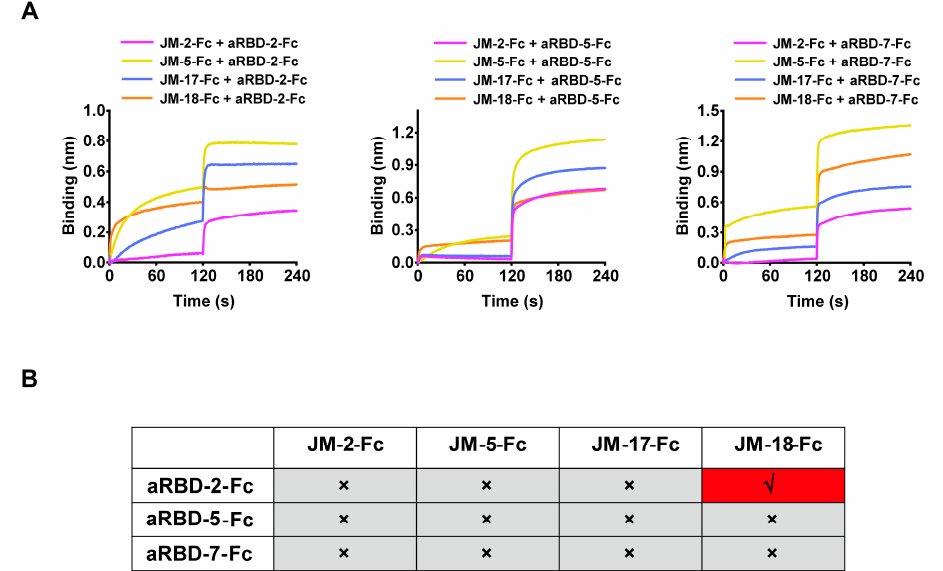
Figure 6. Epitope competition results between the four VNAR-Fc fusions and alpaca-derived VHHs by BLI. ( A ) The competition determined by binding signal transition of shark-derived VNAR-Fc fusions and alpaca-derived VHH-Fc fusions. ( B ) The summarized table for epitope competition of nanobodies from shark and alpaca. The red and gray colors indicate competitive and noncompetitive relationships, respectively.